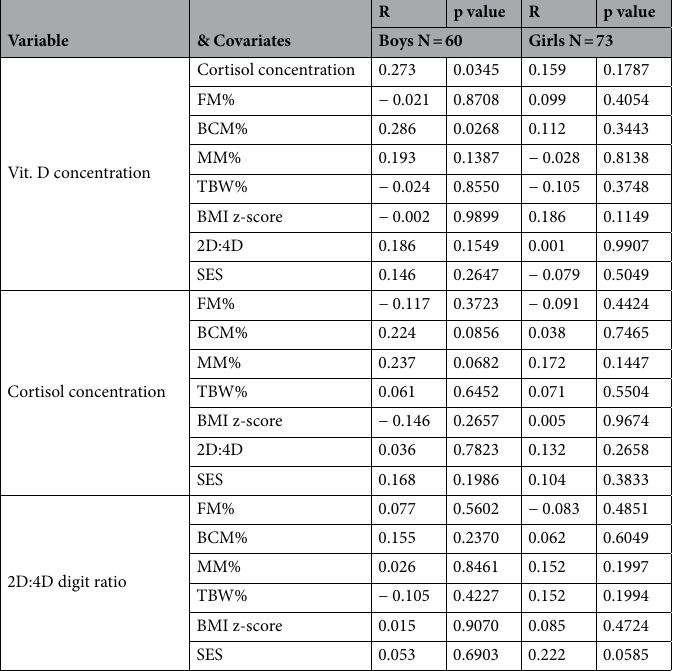
Table 2. Spearman correlations between the investigated variable. Bonferroni correction threshold of significance p <